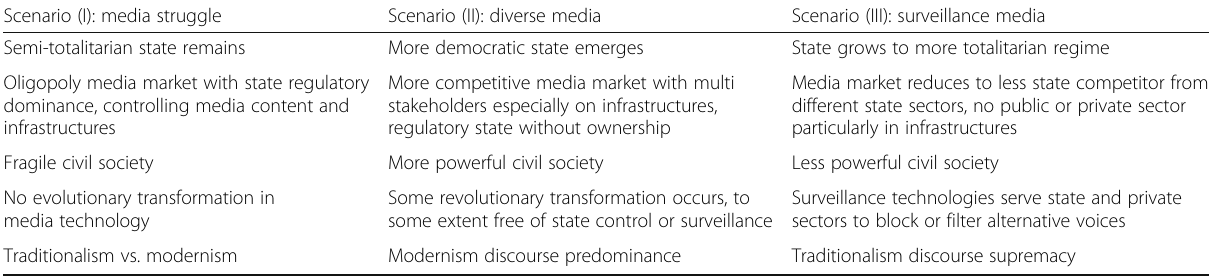
Table 4 Possible scenarios for the future of media and politics in Iran Scenario (I): media struggle Scenario (II): diverse media Semi-totalitarian state